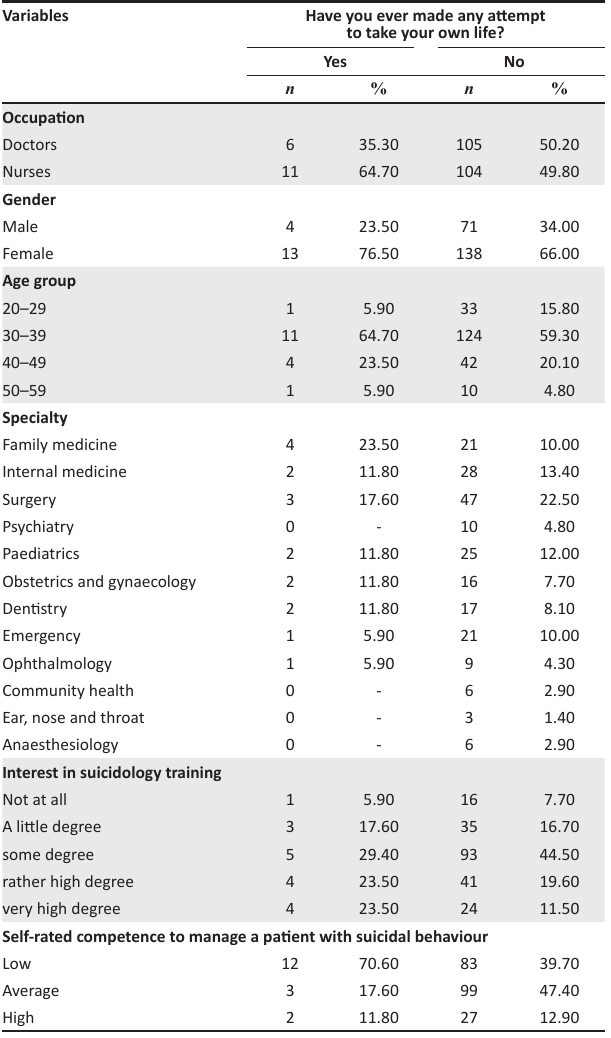
TABLE 2: Suicide attempt profile of the sampled population. Variables